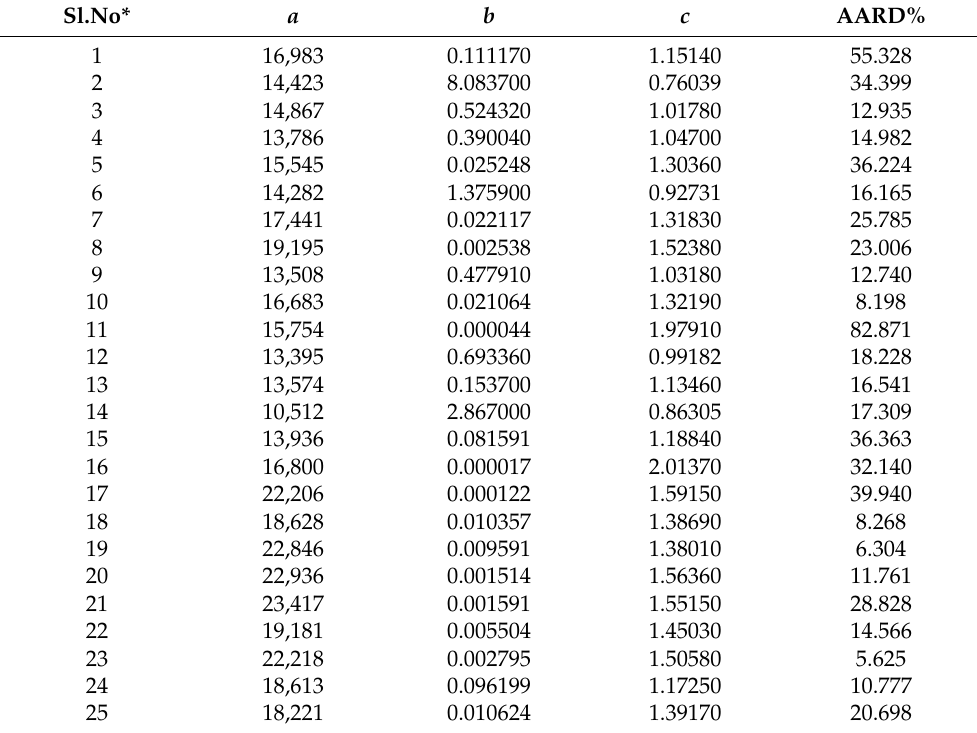
Table 3. Correlation results of the three parameter solid–liquid equilibrium model (Equations (10)–(12)).